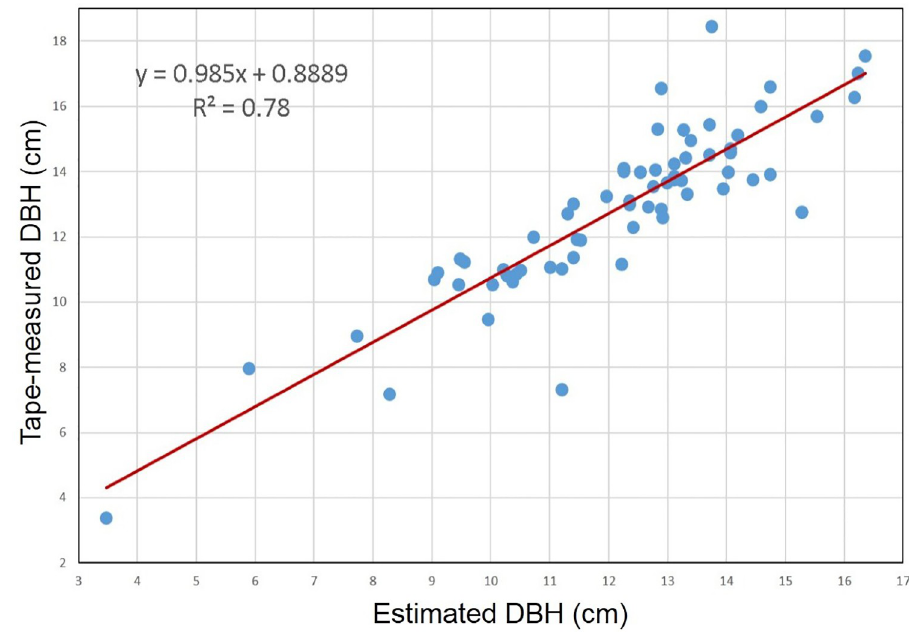
Fig 9. The scatterplot of the tape-measured DBH and the estimated DBH.